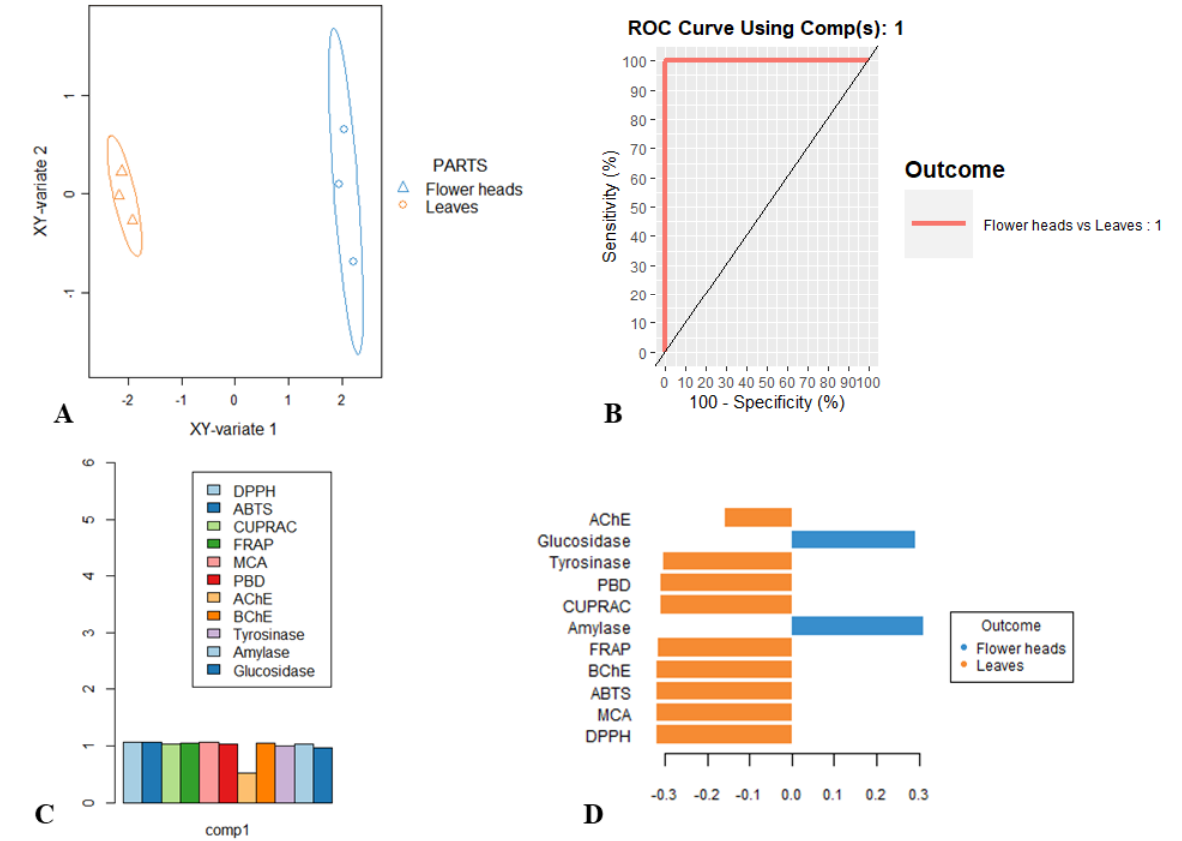
Figure 3. PLS-DA analysis on the bioactivities of C. alpina. ( A ) Scatter plot. ( B ) ROC curve. ( C ) VIP score plot. ( D ) Loading plot.